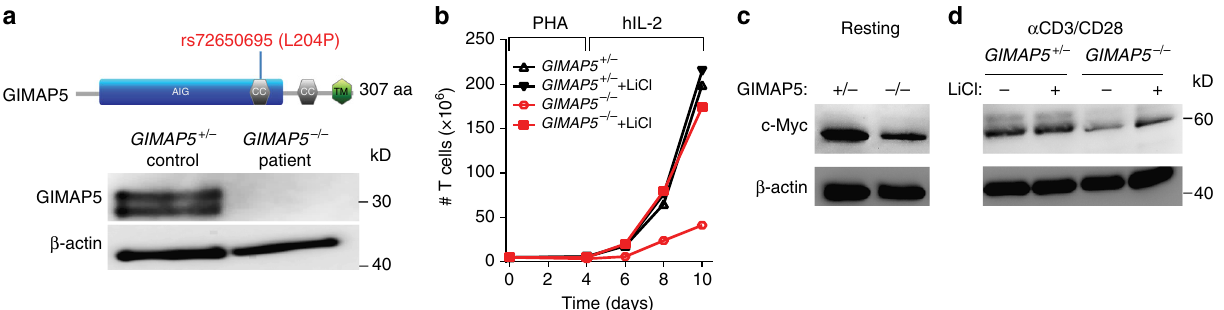
Fig. 7 A human loss-of-function mutation in GIMAP5 results in a similar T cell de fi ciency. a Whole-exome sequencing uncovered a homozygous variant (SNP: rs72650695), causing an L204P amino acid change in GIMAP5, resulting in complete loss of GIMAP5 protein expression in T cells. b Impaired expansion of CD3 + T cells from GIMAP5 − / − patient compared to heterozygous control cells following stimulation with PHA (4 days) and IL-2 (days 4 – 10). The proliferation capacity is restored in the presence of LiCl. Experiment is representative of three independent experiments from samples obtained several months apart. Immunoblot analysis of control and GIMAP5 − / − CD3 + T cells shows reduced c-Myc expression ( c ) at resting conditions and ( d ) after 2-day restimulation with α CD3/ α CD28 ± 5 mM LiCl. Immunoblot was repeated twice with an identical